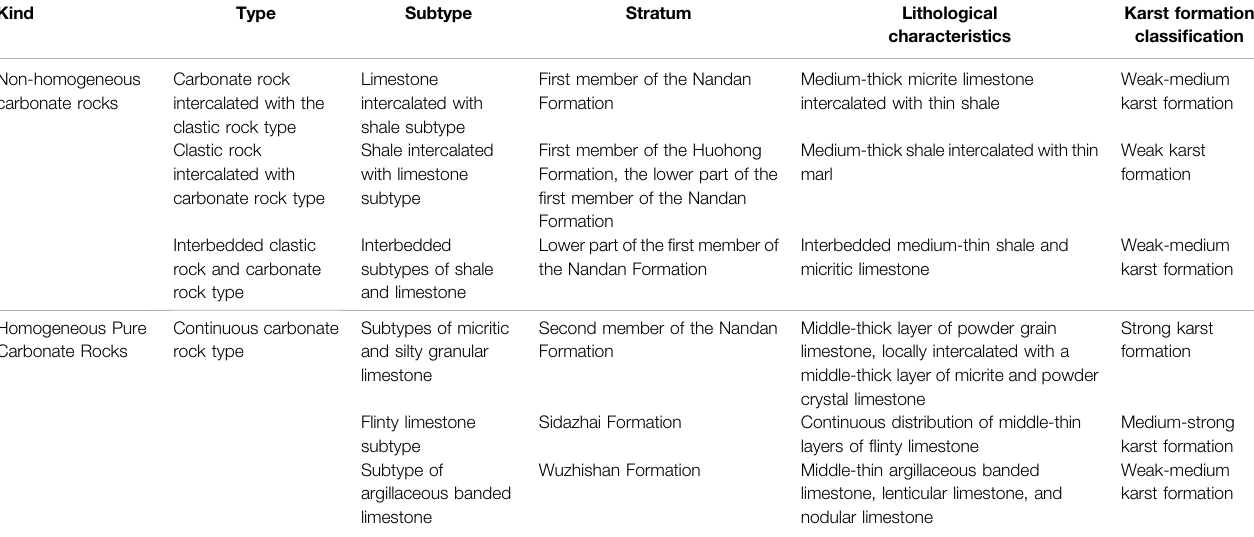
TABLE 2 | Classi fi cation table of carbonate karst formation types in the Qiannan area.